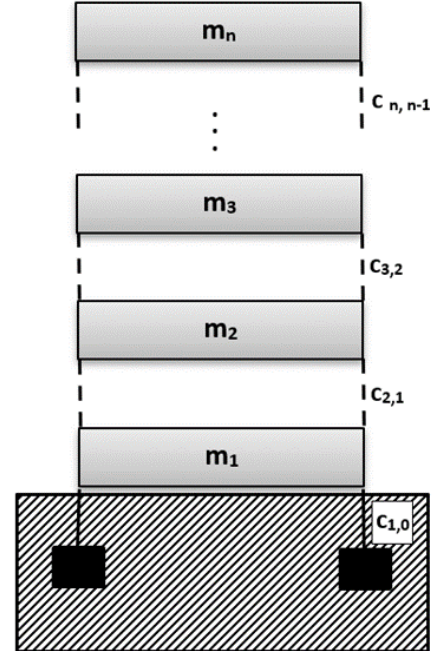
Figure 1. Model of the sheared